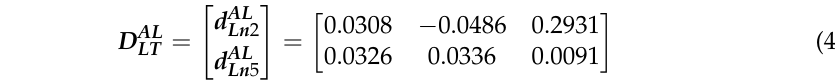
Elastic Modulus Poisson Ratio (MPa)